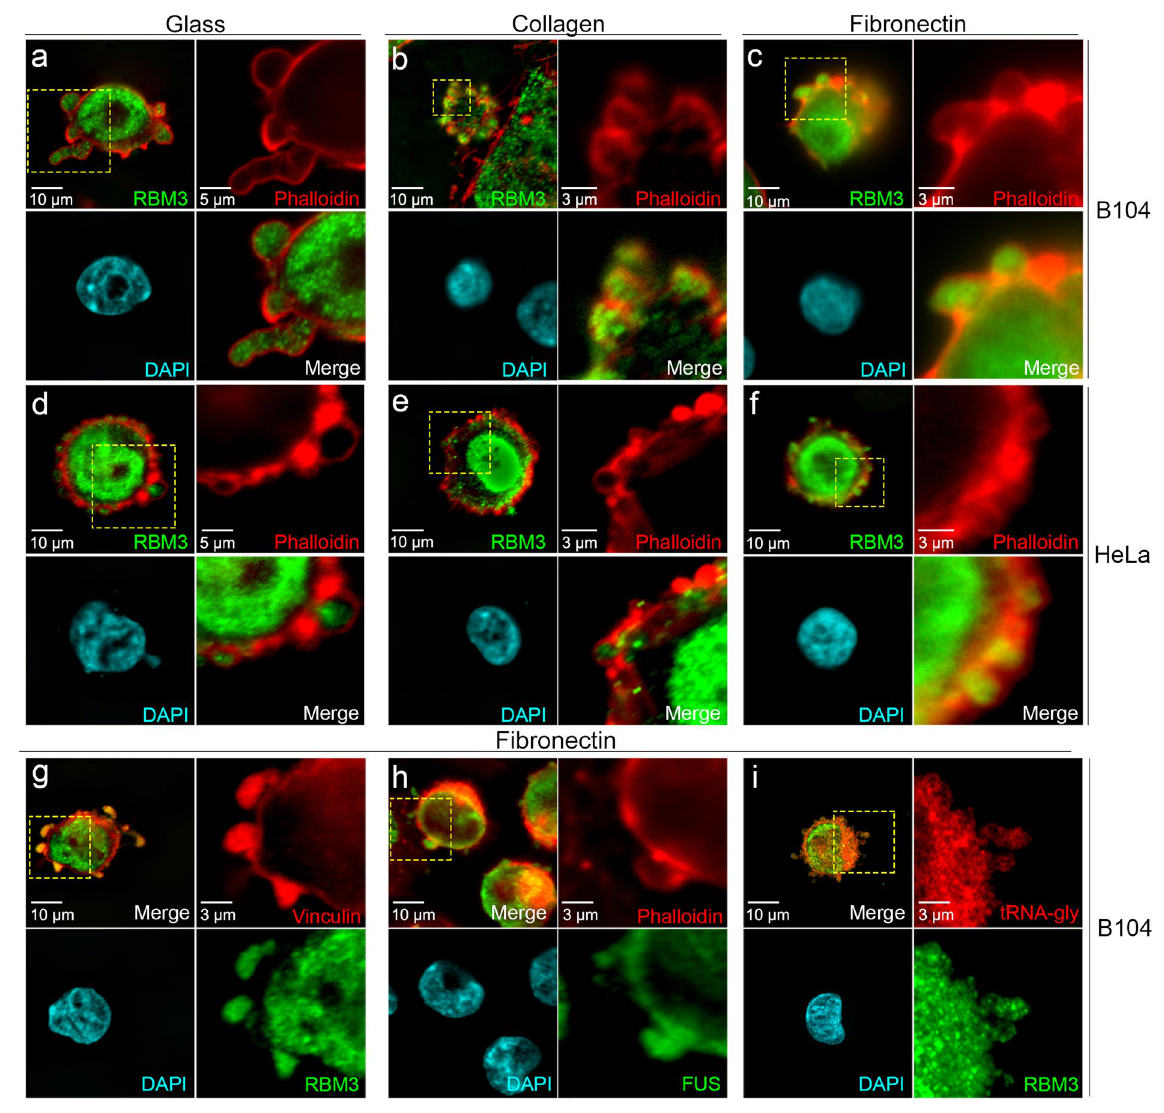
Figure 1. Localization of RBM3 to SICs in different cell types and plating conditions. Images of RBM3 (green), F-actin (red, phalloidin), and DAPI-stained nuclei (blue) in B104 cells ( a–c ) and HeLa cells ( d–f ) 30 minutes after plating onto glass, collagen, and fibronectin. For each cell type and substrate in panels a through f, upper right sub-panels show close-ups of F-actin distribution in regions (hatched yellow rectangles) at cell margins that contain SICs; sub-panels in lower right show the overlay of RBM3 with F-actin. ( g–i ) Images of B104 cells grown on fibronectin that were labeled for RBM3 and other SIC components by immunofluorescence, and for tRNA by FISH: cells were double labeled for ( g ) RBM3 (green) and the SIC component vinculin (red); ( h ) FUS (green) and F-actin (red); and ( i ) RBM3 (green) and tRNA-glycine